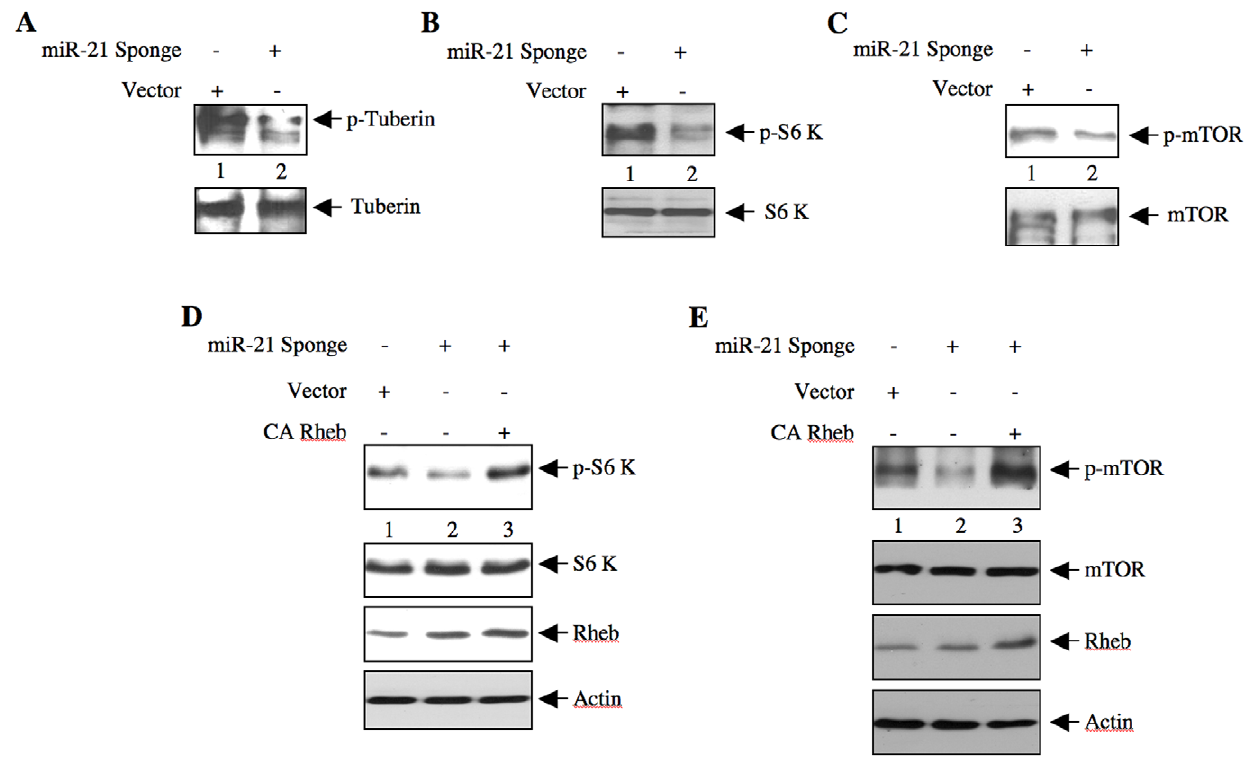
Figure 7. miR-21 regulates phosphorylation of tuberin and activation of mTOR in renal cancer cells. ACHN cells were transfected with miR-21 Sponge or vector. The cell lysates were immunoblotted with phospho-tuberin (Thr-1462), tuberin (panel A), phospho-S6 kinase (Thr-389), S6 kinase (panel B), phospho-mTOR (Ser-2448) and mTOR (panel C). miR-21 uses Rheb activation for TORC1 activity. ACHN cells were cotransfected with miR-21 Sponge and CA Rheb plasmid. The cell lysates were immunoblotted with phospho-S6 kinase (Thr-389), S6 kinase (panel D), phospho-mTOR (Ser-2448) and mTOR (panel E).